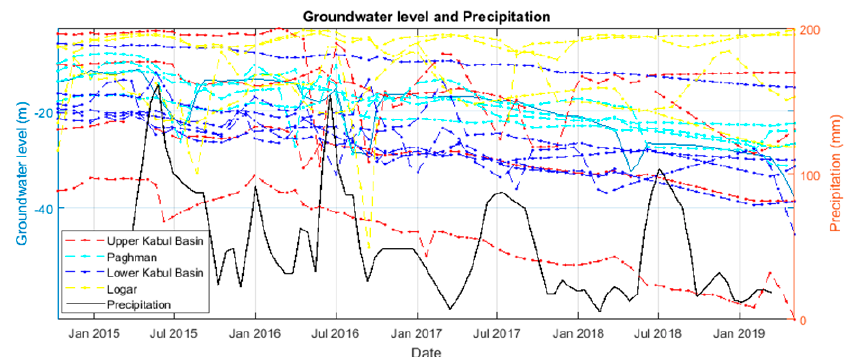
Figure 2. Observed groundwater drawdown in fourteen wells across the network. Locations of the wells are shown in Figure 5. Precipitation time-series is retrieved from CRU TS 4.03 [38].